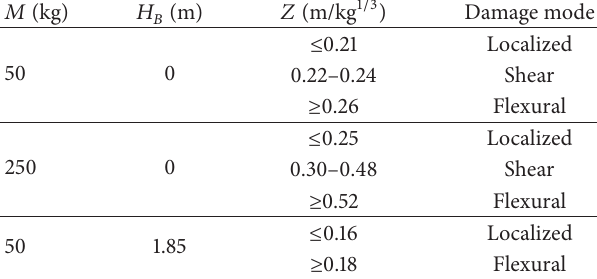
Table 3: Possible damage modes of the CFST